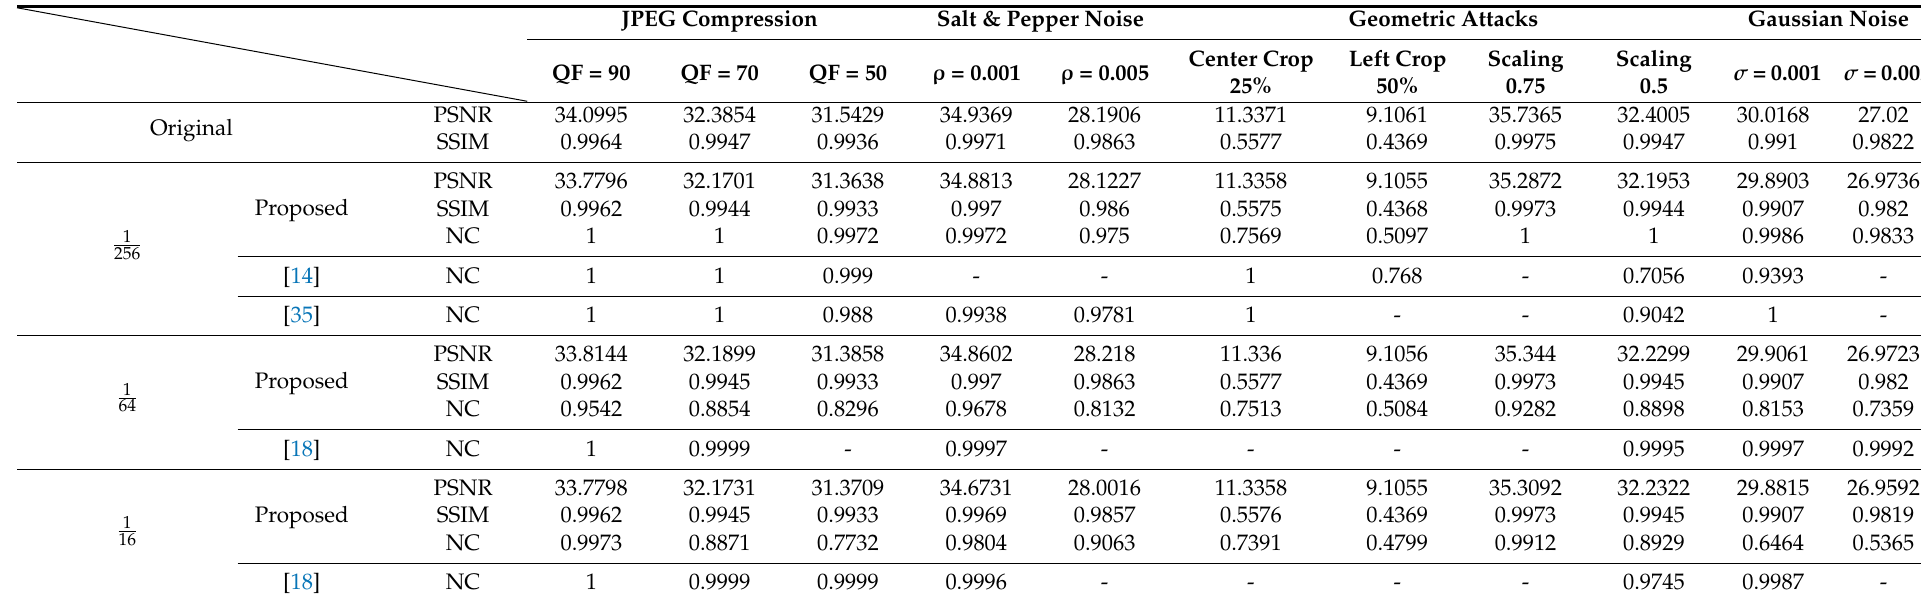
Table 2. Experimental results under different